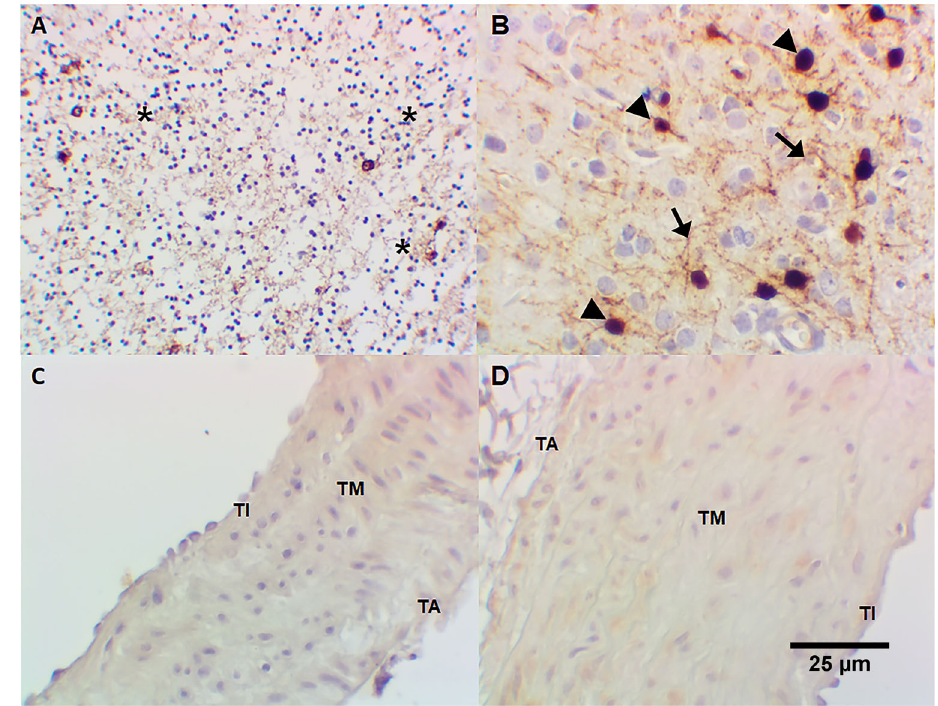
Figure 9. Detection of calretinin (neural/neuronal markers) by immunohistochemistry: A , diffuse positivity for calretinin in human cerebellum neuropil (*); B , calretinin positivity in Callithrix spp. central nervous system (glial nuclei [arrowhead] and glial fi bers [black arrow] are positive); C , absence of calretinin in tunica intima (TI), media (TM), and adventitia (TA) of Callithrix spp. pulmonary artery; D , absence of calretinin in Callithrix spp. aorta (both tunicae intima and media are negative). Immunoperoxidase, 400 (cid:3) (original magni fi cation), scale bar 25 m